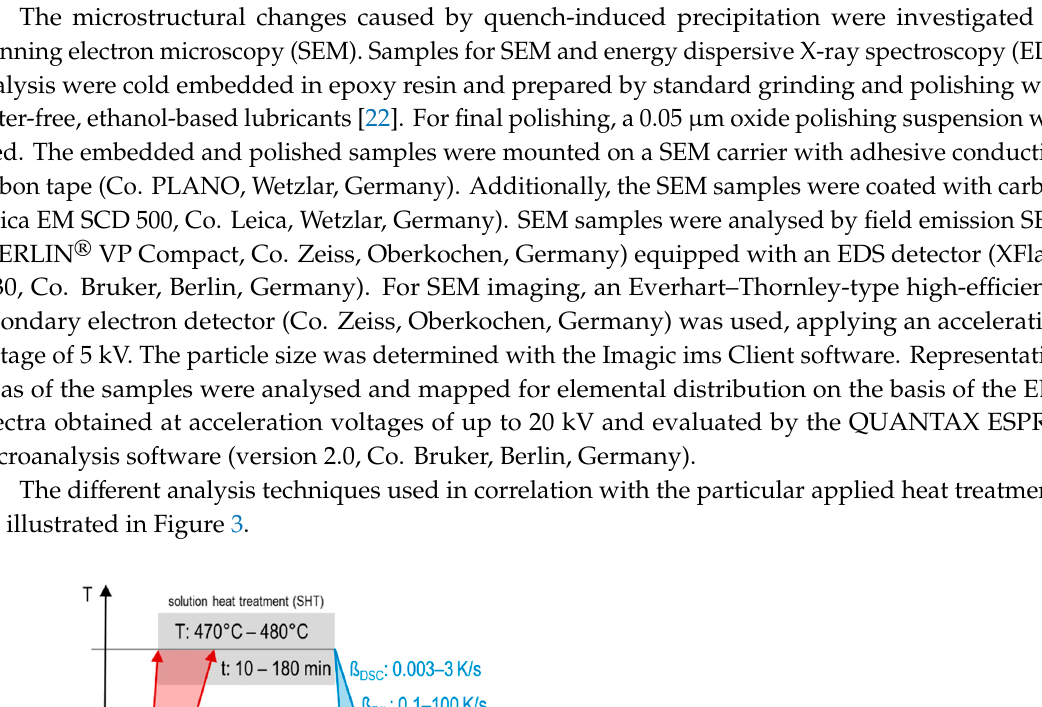
Figure 2. Evaluation procedure dilatometric analysis: Alloy 7068, solution annealing 480 ◦ C 10 min, and cooling rate 0.1 K / s. ( a ) raw strain data of sample and baseline measurement as well as strain di ff erence of these two and ( b ) derivation of strain di ff erence.